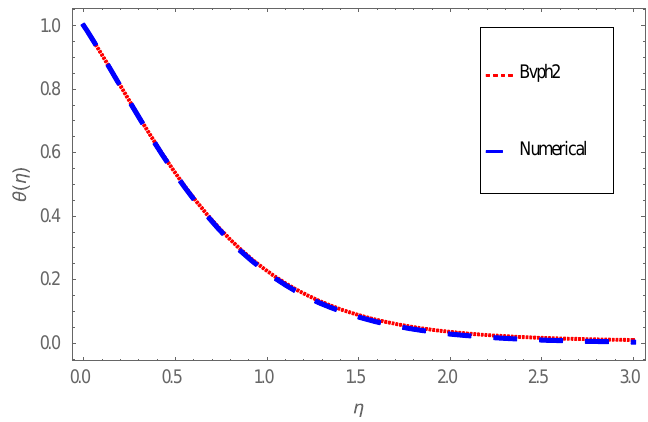
Figure 16. Temperature comparison.